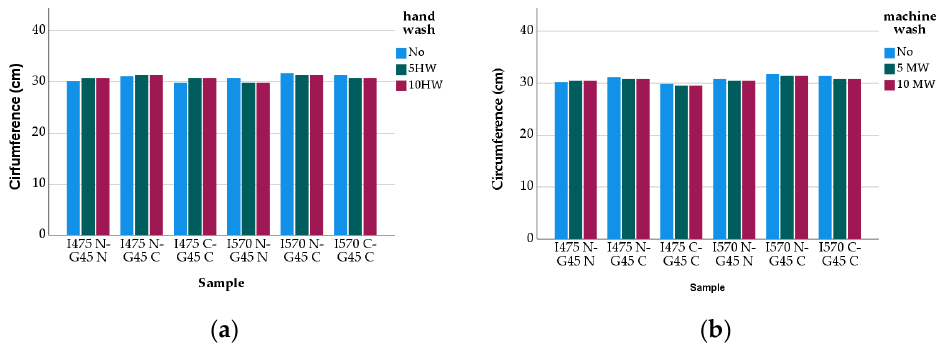
Figure 3. Circumference Change: ( a ) Hand-wash vs. ( b ) Machine-wash.